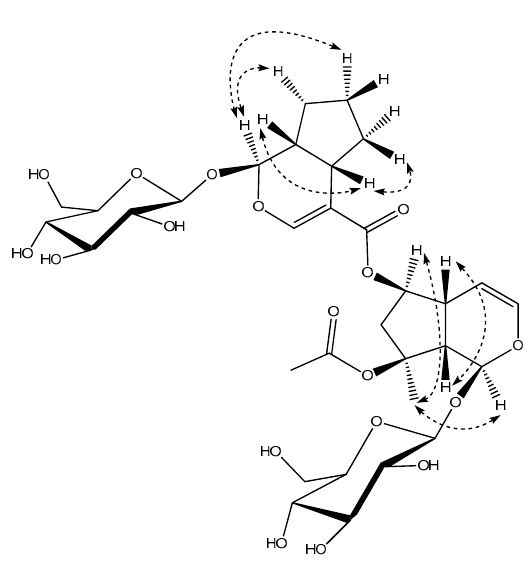
Figure 3. Selected Nuclear Overhauser Effect Spectroscopy (NOESY) correlations for compound 1 .